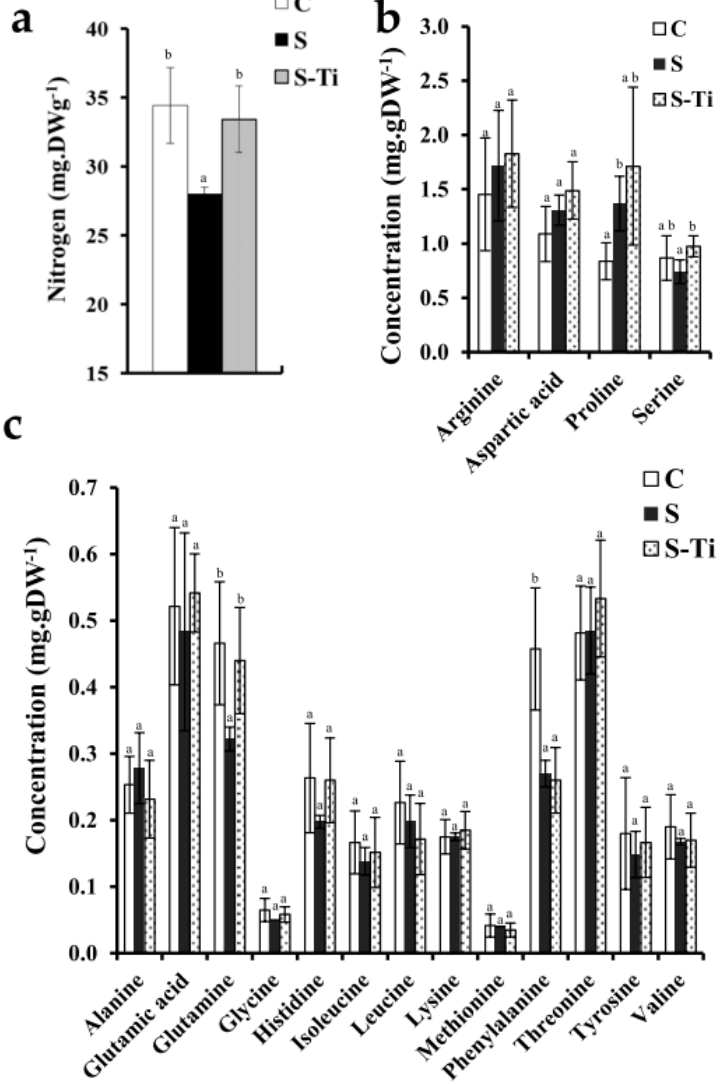
Figure 6. ( a ) nitrogen rate per plant in shoots at harvest time for all treatments; ( b , c ) free amino acids content. Bars represents standard deviation and different letters means statistical differences ( p < 0.05) between treatments.